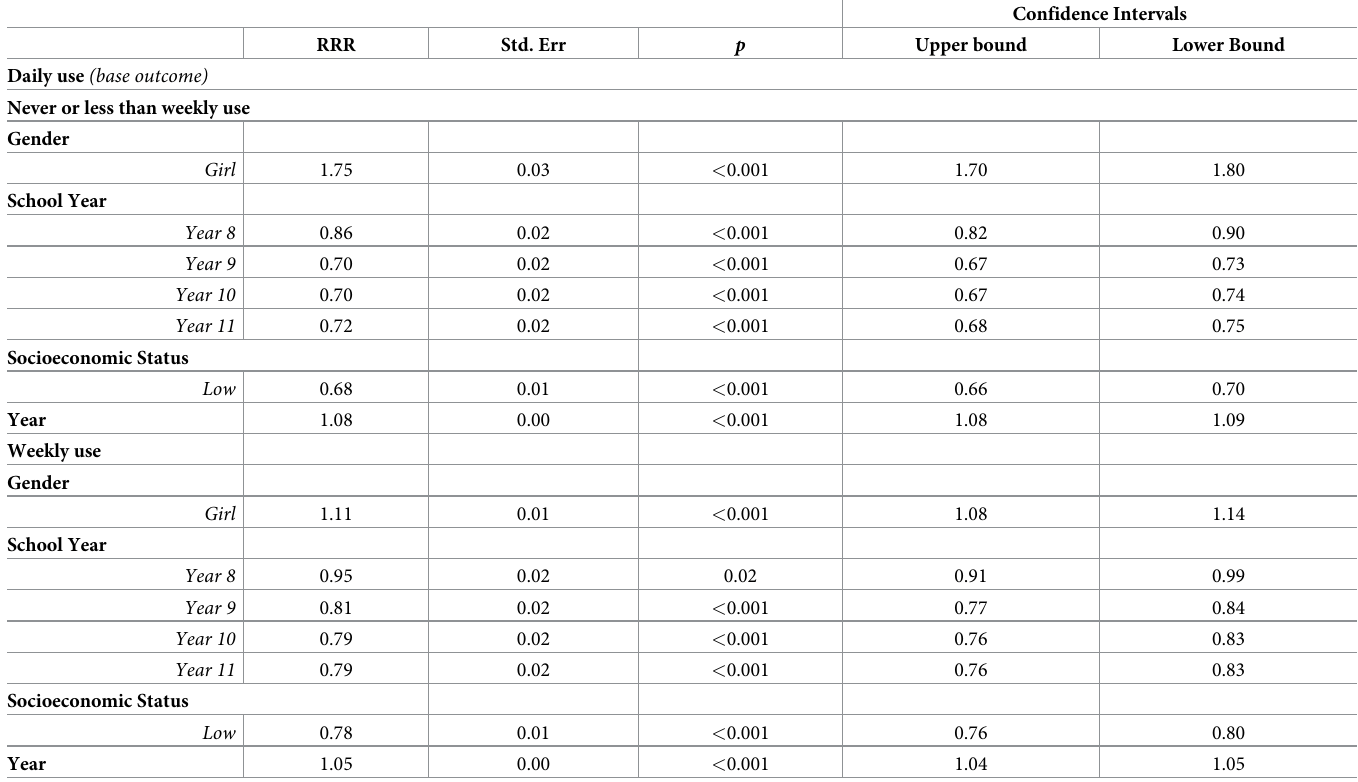
Table 2. Multinomial regression of SSB consumption and sociodemographic characteristics with daily use as the reference category (n = 157,564).